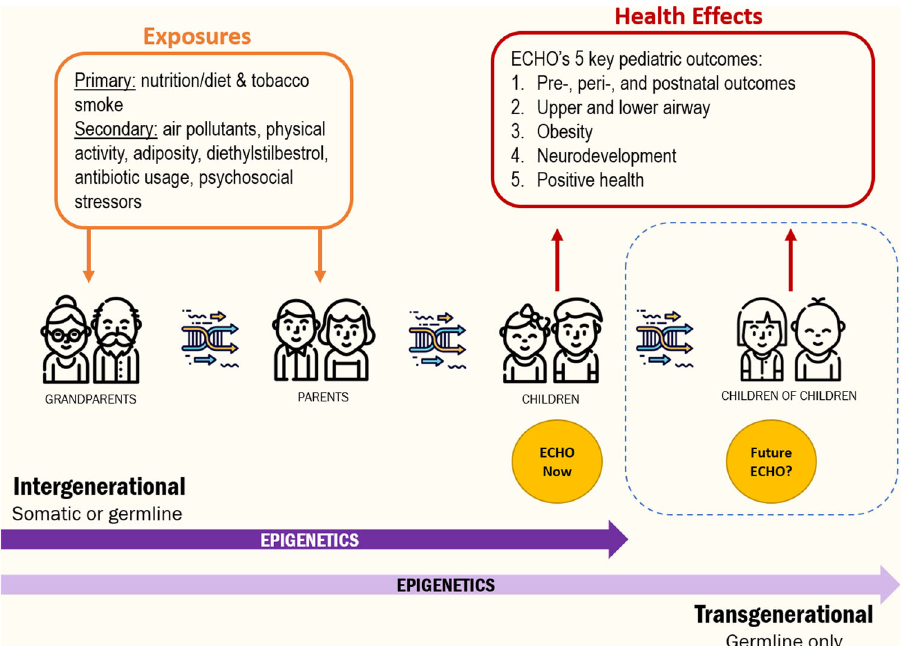
Fig. 2 Opportunities in ECHO for understanding the in fl uences of the environment on child health across generations. The Environmental in fl uences on Child Health Outcomes (ECHO) program, created in 2016, is an NIH-funded national program that supports existing observational and intervention studies to answer important questions about key developmental areas, including pre-, peri-, and early postnatal outcomes, airway conditions, obesity, and neurodevelopment. Exposures of interest include nutrition, tobacco smoke, pollutants, physical activity, drug usage, and stress. The ECHO program offers a unique platform and opportunity in which to explore the health effects of exposures, including more contemporaneous ones, that are present or have far- reaching consequences across